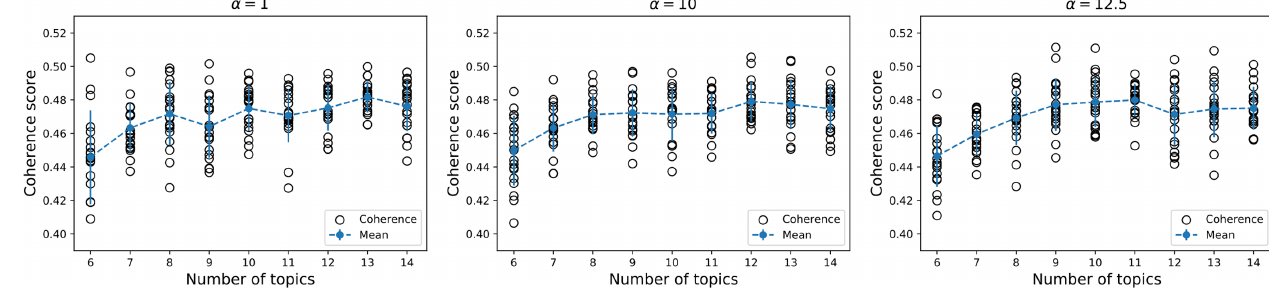
FIG. 6. Graphs of elbow plot with different document-topic mixtures ( α